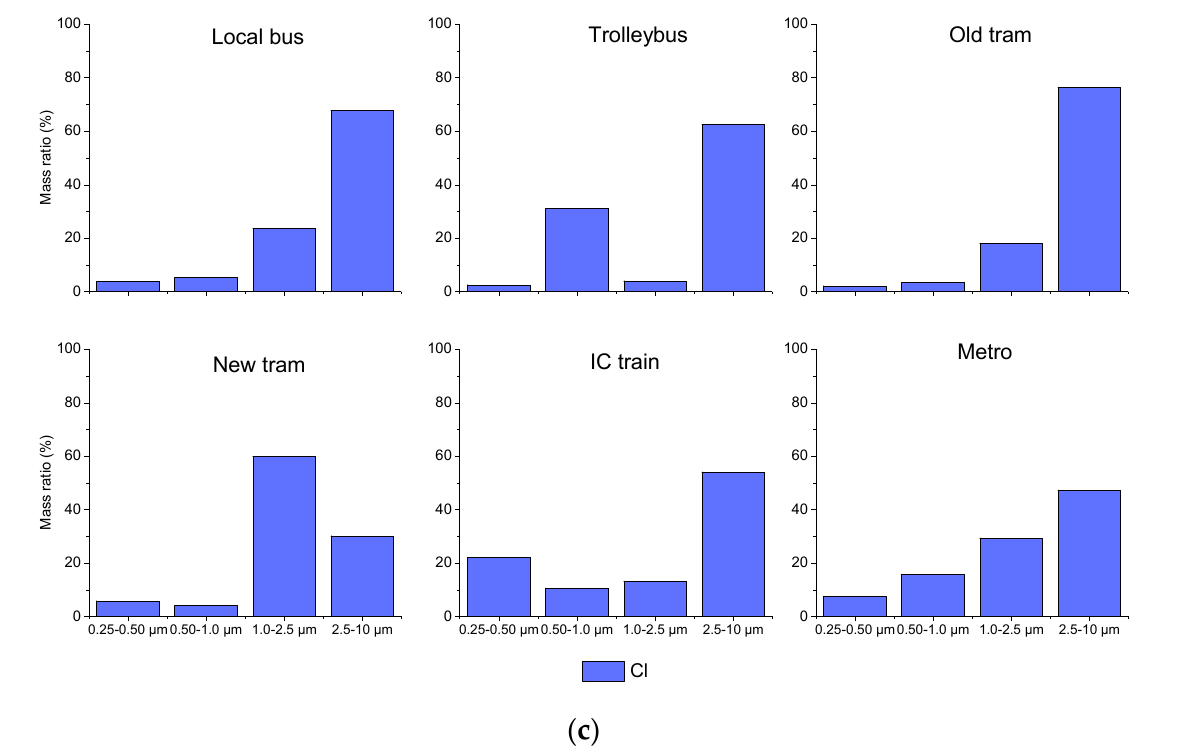
Figure 3. Silicium ( a ); sulphur ( b ); chlorine ( c ) mass size distributions in different vehicles in 2014.